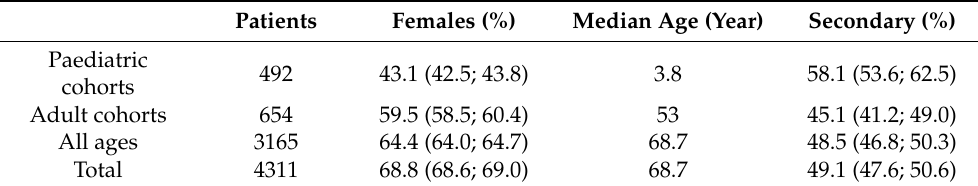
Table 2. Summary of data on patients diagnosed with warm type autoimmune haemolytic anaemia (wAIHA) divided into groups according to age characteristics of the studies. The extracted data are number of patients, the female to male ratio, median age in years, and number of patients with assumed secondary